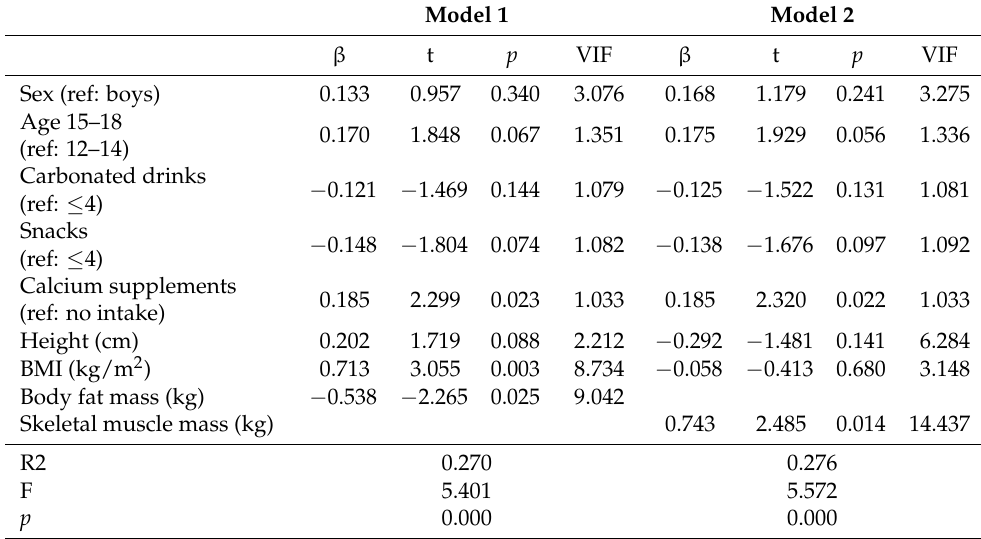
Table A3. Regression analysis including